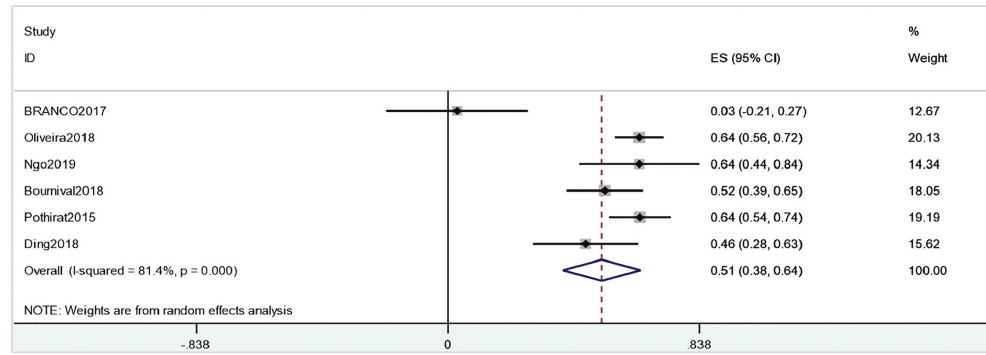
Figure 7. Forest plot of errors in SMI use. Abbreviation: SMI, soft mist inhalers.